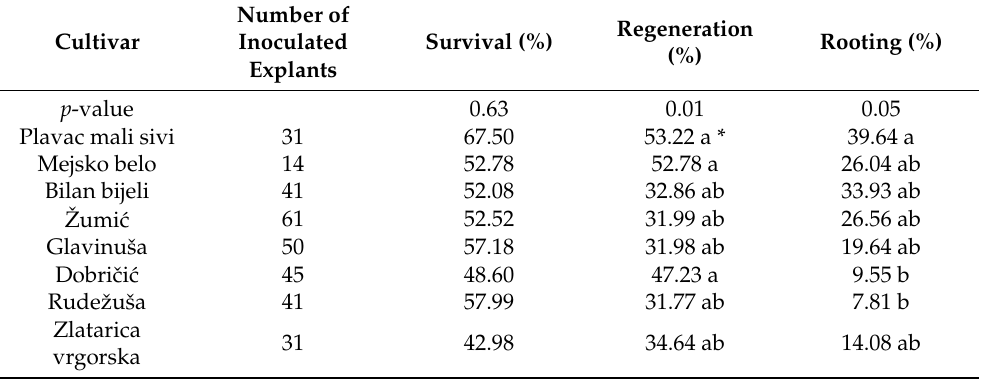
Table 2. Effect of the cultivar on the growth and development of in vitro meristem